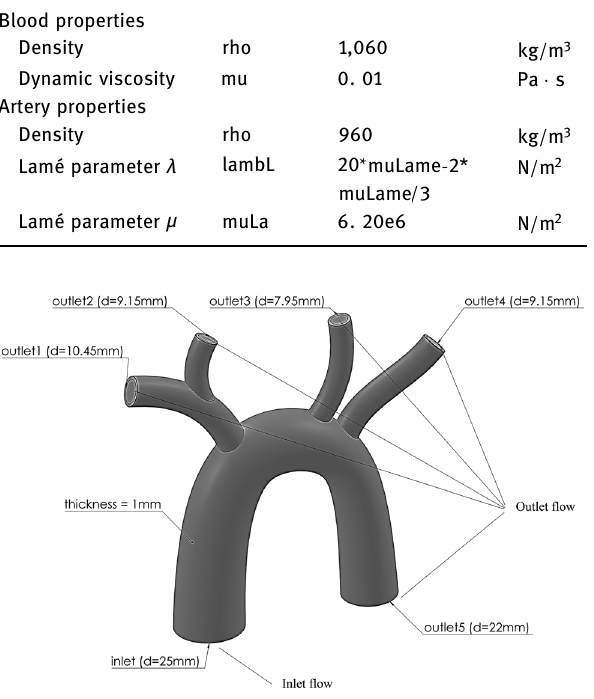
Figure 2: Geometry